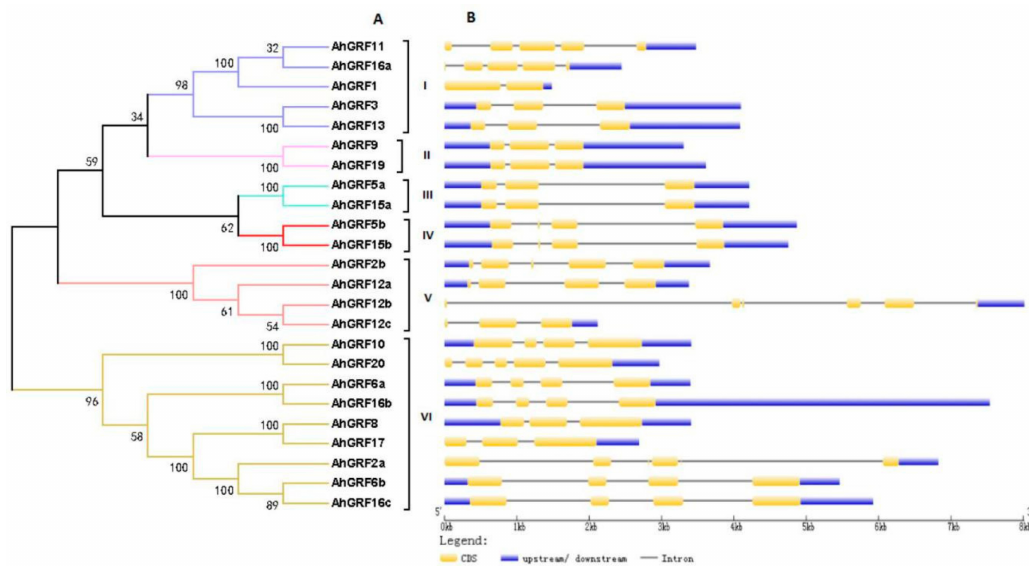
Figure 1. Exon–intron structures of AhGRF genes according to their phylogenetic relationships. ( A ) An unrooted phylogenetic tree was constructed based on the amino acid sequences. ( B ) Exon–intron structure analysis of AhGRF genes performed using the online tool GSDS. The lengths of exons and introns of each AhGRF gene are drawn to scale.